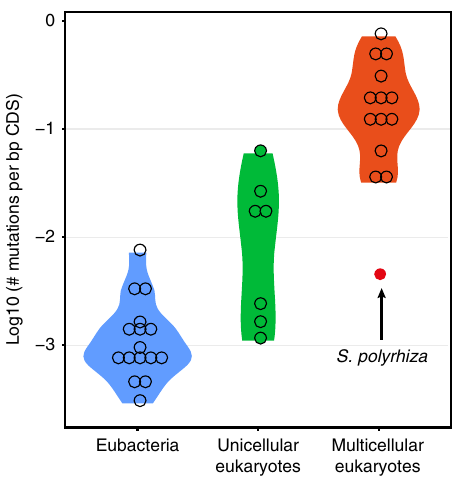
Fig. 2 Estimated mutation rates in protein-coding regions among different organisms. The violin plots of log 10 -transformed numbers of mutations per base pair of protein-coding genome sequences (CDS) per generation for eubacteria, unicellular eukaryotes and multicellular eukaryotes, respectively. The kernel probability density is shown. Each circle indicates the estimate for one species. The arrow highlights the mutation rate in S. polyrhiza . Except for the mutation rate in S. polyrhiza , the plotted data were extracted from previous studies (Supplementary Data